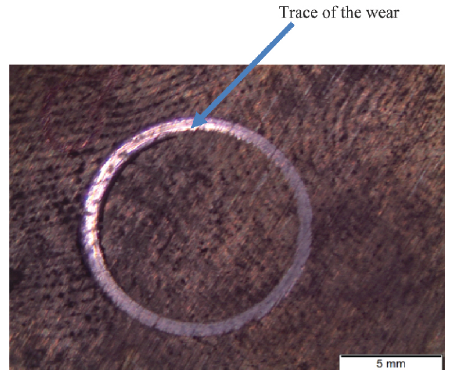
O (pin) and cermets (disc). 2 3